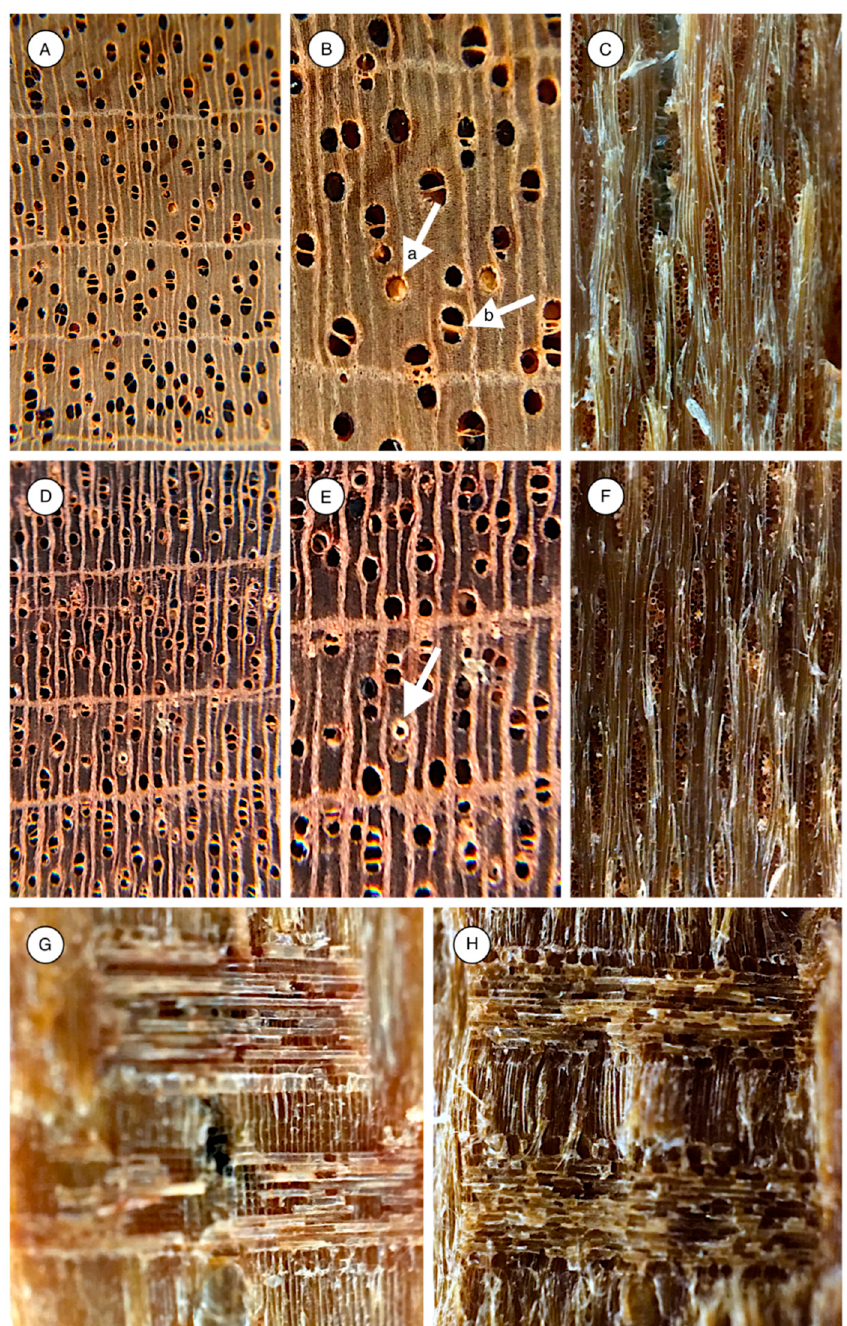
Figure 6. Elements visible with 24 × and 400 × lenses in hardwoods. Cedrela odorata L. ( A ) Vessels solitary and in multiples of 2 or 3 and marginal axial parenchyma (24 × lens). ( B ) ( a ) Gum deposits; ( b ) scanty paratracheal axial parenchyma (400 × lens). ( C ) Non-storied rays (400 × lens). Swietenia spp. ( D ) Vessels solitary and in multiples of 2 or 3 and marginal axial parenchyma (24 × lens). ( E ) White deposits (400 × lens). Swietenia macrophylla King. ( F ) Storied rays (400 × lens). ( G ) and ( H ) Procumbent body ray cells with one row of upright and / or square marginal cells in Cedrela odorata and Swietenia spp. (400 × lens).